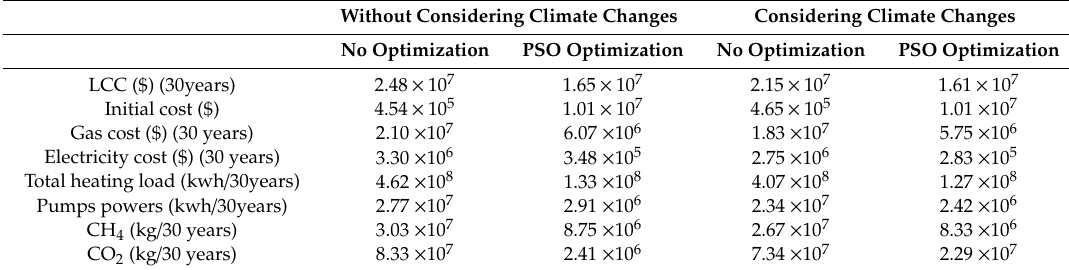
Table 10. Comparison of economic and environmental